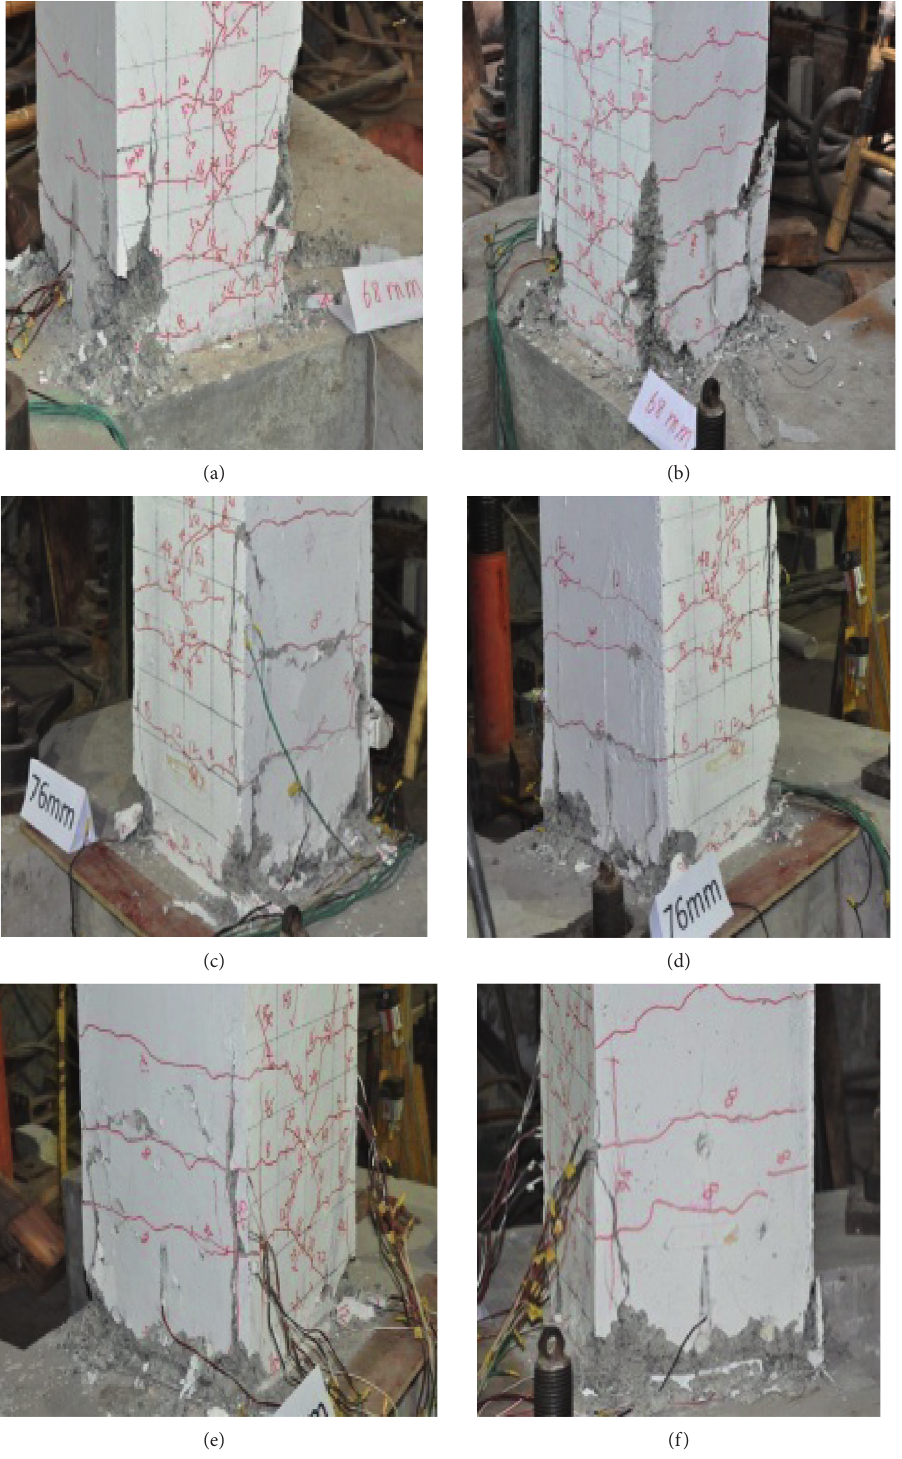
Figure 9: Crack patterns of specimens at displacement limit state. (a) Left side of XZ1. (b) Right side of XZ1. (c) Right side of YZ1. (d) Left side of YZ1. (e) Left side of YZ2. (f) Right side of